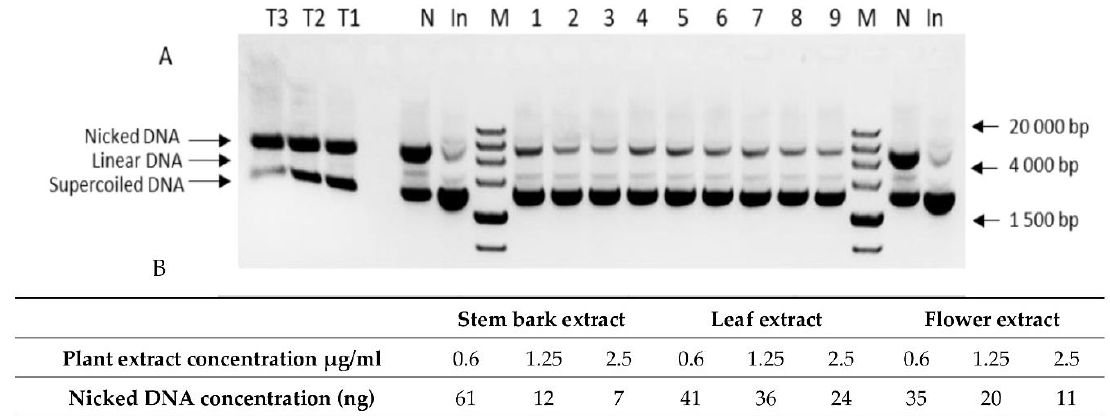
Figure 1. DNA nicking protection assay with ( A ) 1.5% agarose gel electrophoresis, and ( B ) relative concentration of necked plasmid DNA. 1–3— K. paniculata stem bark extract at concentrations of 0.6, 1.25, and 2.5 μg/ml; 4– 6 — K. pаniculаtа leaf extract at concentrations of 0.6, 1.25, and 2.5 μg /mL; 7 –